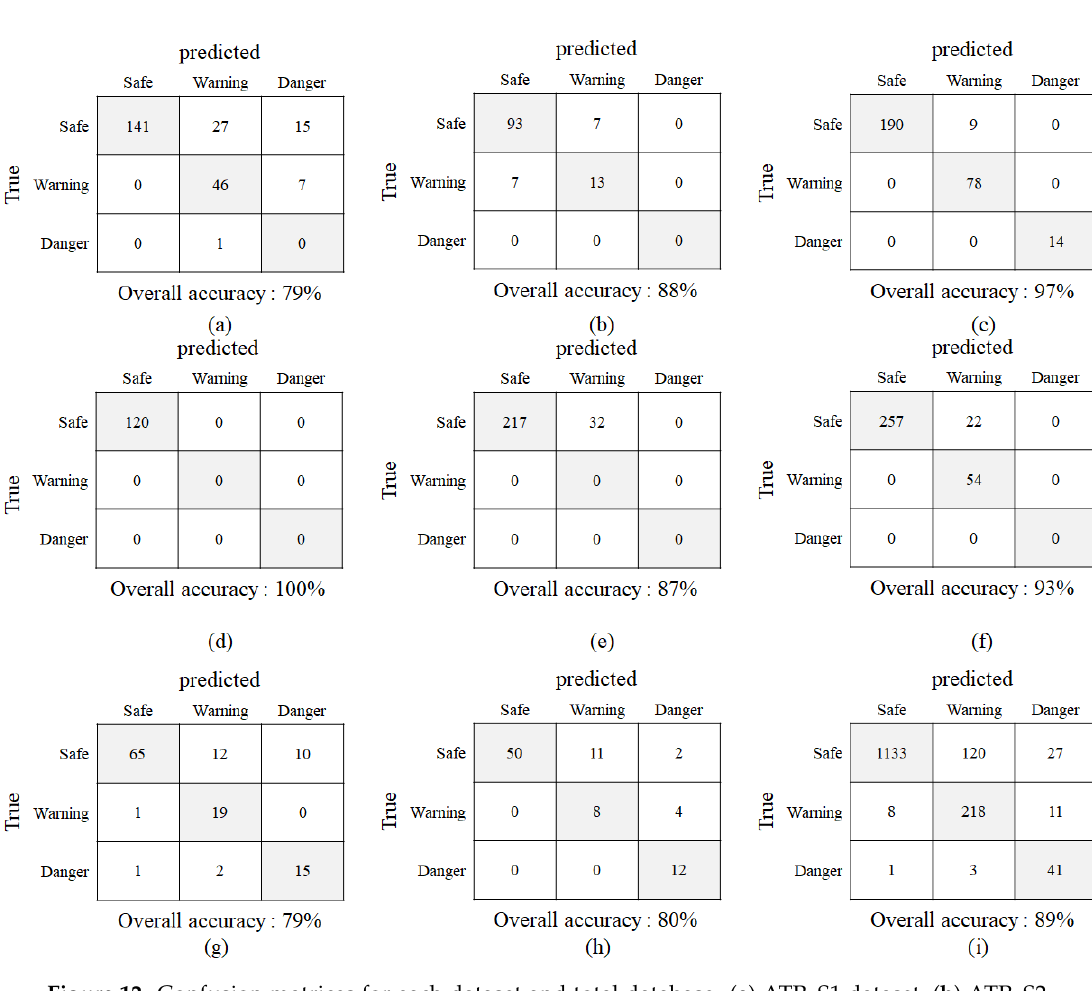
Figure 12. Confusion matrices for each dataset and total database. ( a ) ATP_S1 dataset, ( b ) ATP_S2 dataset, ( c ) ATP_S3 dataset, ( d ) ATP_S4 dataset, ( e ) ATP_S5 dataset, ( f ) STORE_S1 dataset, ( g ) UNIV_S1 dataset, ( h ) UNIV_S2 dataset, ( i ) Total: The columns of the matrix denote ground truths made by humans, and the rows of the matrix denote decisions made by the proposed system. All correct predictions are located in the diagonal of the table.